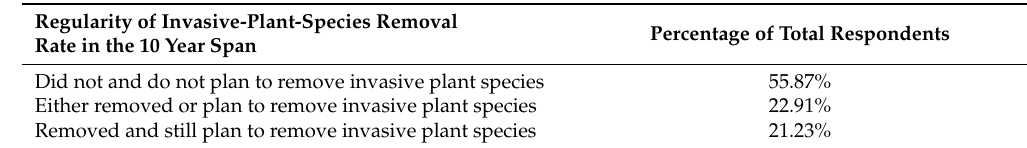
Table 1. Percentage distribution of forestland owners’ stated frequency of removing invasive plant species in a 10-year span.